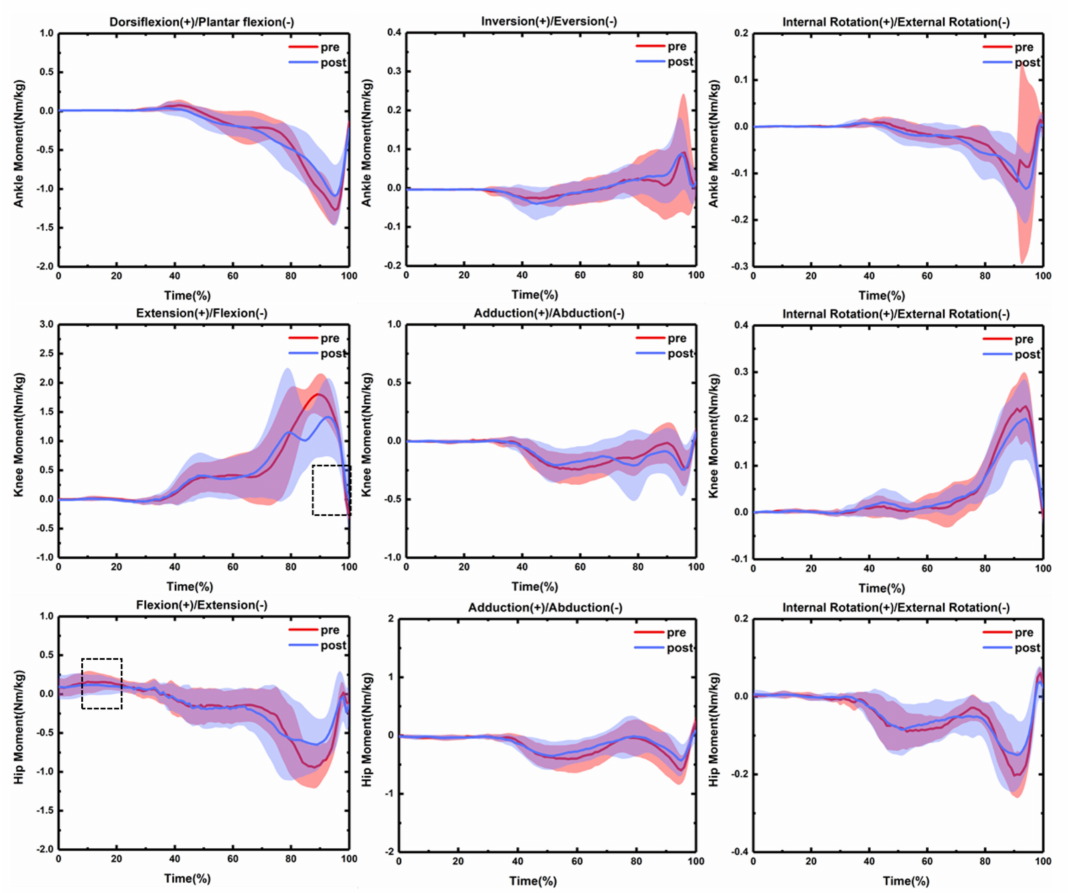
Figure 4. The joint moments between pre- (red solid lines) and post-fatigue (blue solid lines) during the push-o ff phase. Shaded areas mean standard deviation. Black dotted boxes indicate significant di ff erences between the two